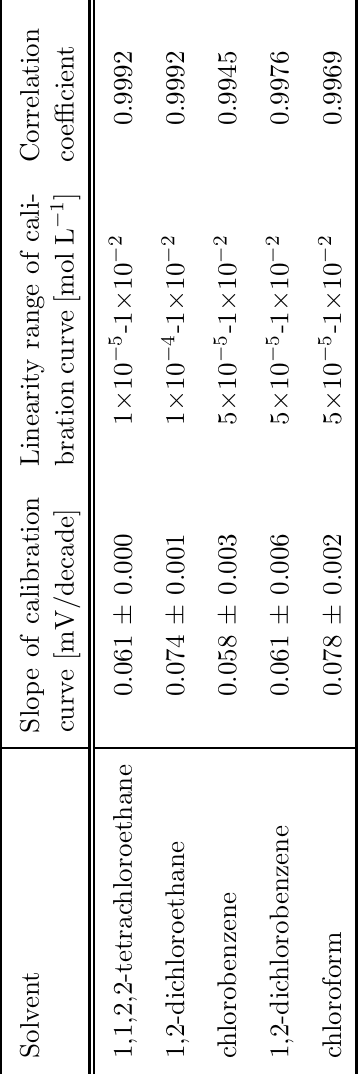
Table 1 Analytical parameters of the electrodes containing studied membrane